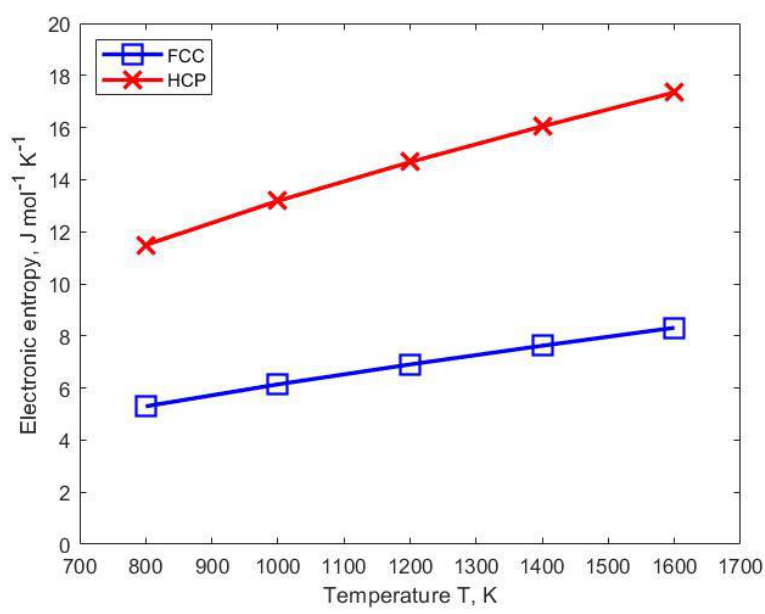
Figure 13. Electronic entropy as a function of temperature for FCC and HCP Ni.